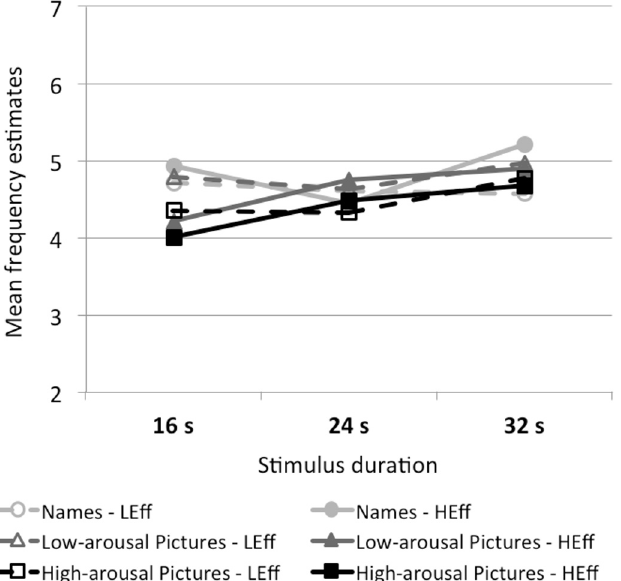
Fig 5. Influence of duration on frequency. Influence of stimulus duration on frequency judgments in the different stimulus-type and physical-effort conditions. Stimuli were presented for 16 s, 24 s, or 32 s. Frequency estimates are averaged per participant over the three levels of presentation frequency. LEff = low physical effort; HEff = high physical effort. The figure shows a systematic covariation of the frequency judgments with presentation duration only in the conditions in which pictures were processed under high